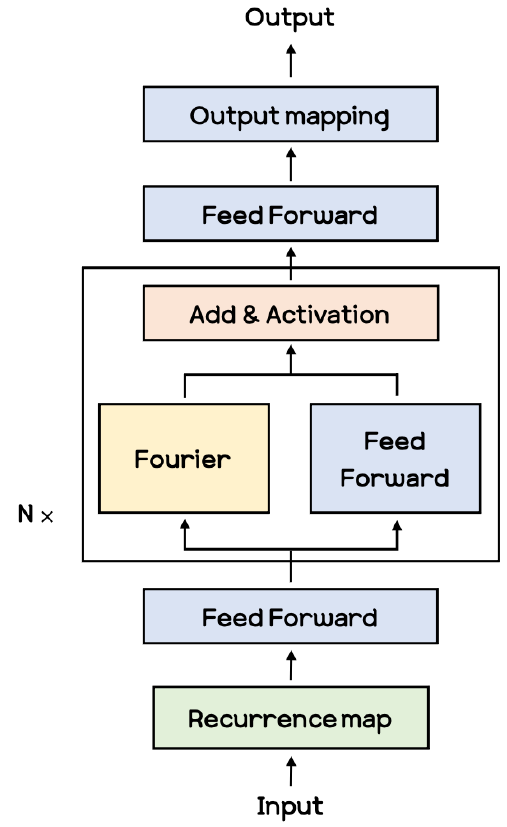
Figure 3. FNO architecture with N Fourier